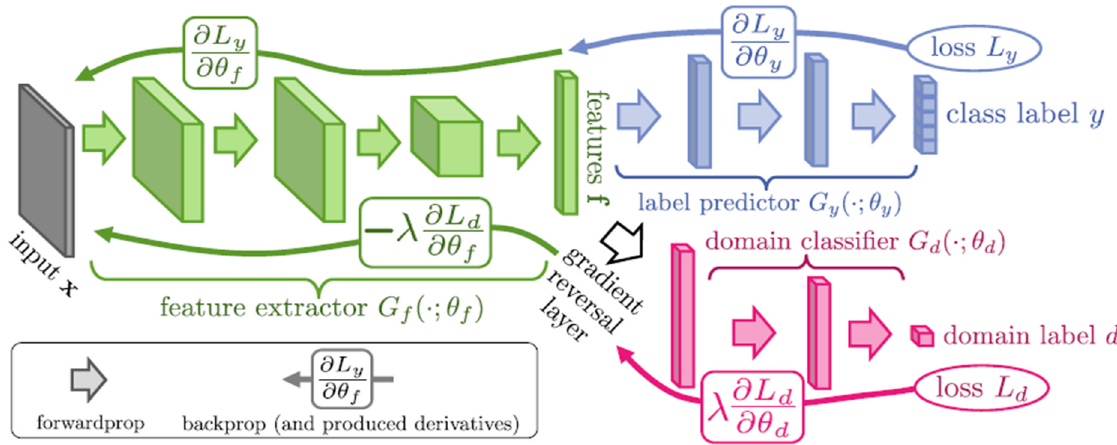
Figure 3. Architecture of the domain adversarial neural network.